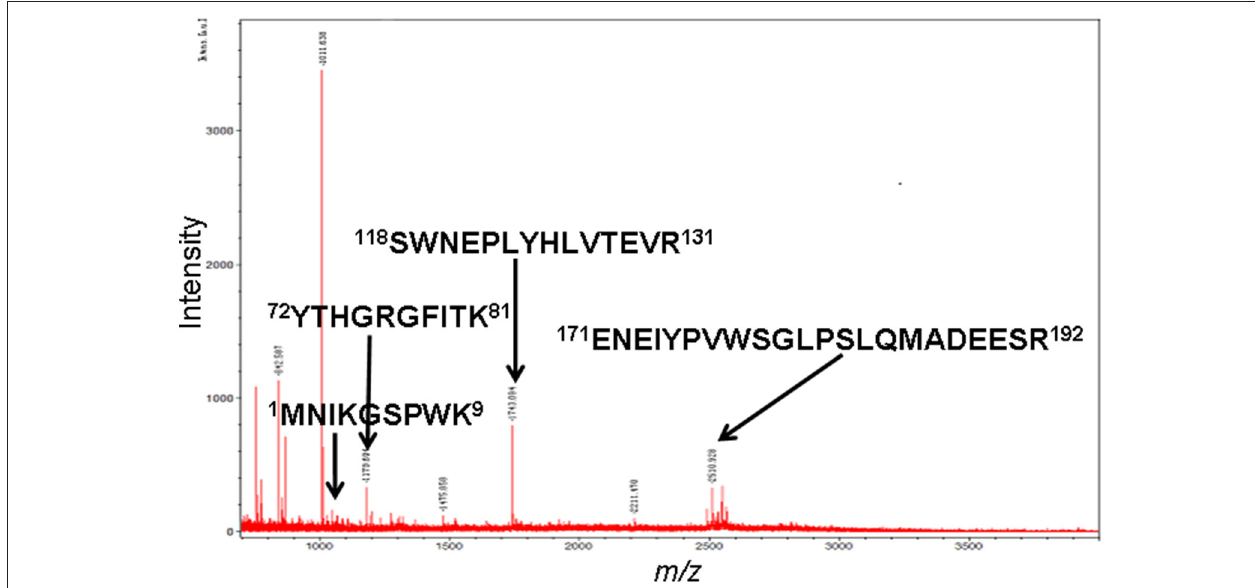
FIGURE 2 | MS spectrum of hPRL that was contained in spot v6.